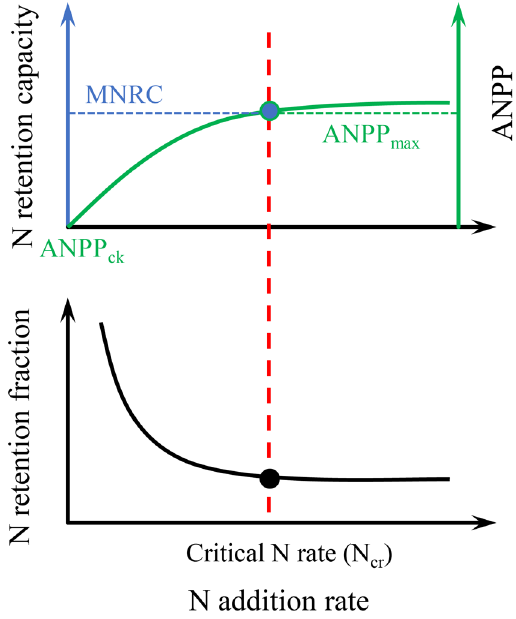
Figure 1. Patterns of plant aboveground net primary productivity (ANPP), N retention capacity and N retention fraction (NRF) response to N addition. ANPP ck is the initial ANPP without exogenous N addition. ANPP max is the saturated ANPP at critical N rate (N cr ). MNRC is the maximum N retention capacity at N cr